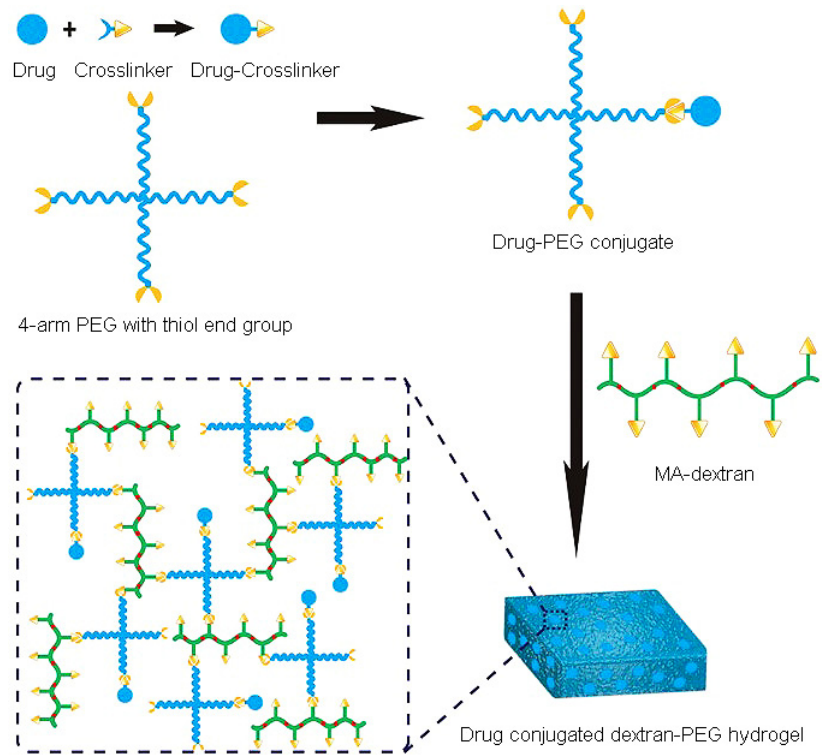
Figure 9. Covalent linkage strategy to bind polymyxin B or vancomycin to a linker via amide bonds, and then to a 4-arm PEG with terminal thiol groups, to allow subsequent linkage to a methacrylate(MA)-dextran polymer. Reprinted with permission from Ref. [150]. Copyright 2017 WILEY-VCH Verlag GmbH & Co. KGaA, Weinheim.